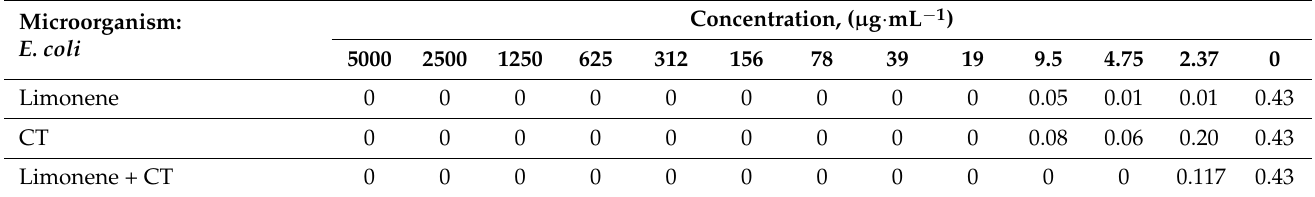
Table 2. Optical densities obtained after 24 h of exposure of E. coli at different